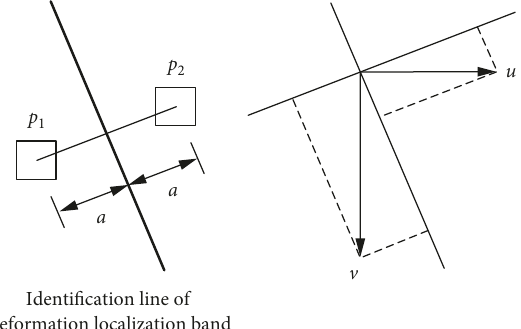
Figure 11: Analytical method of displacement evolution around deformation localization